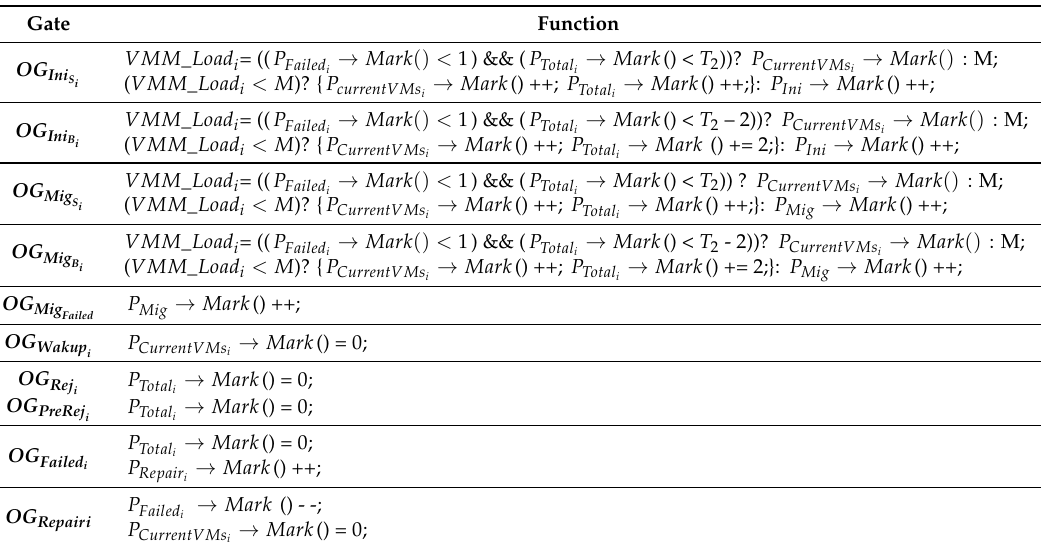
Table 3. Functions of outputs gates of the proposed SAN